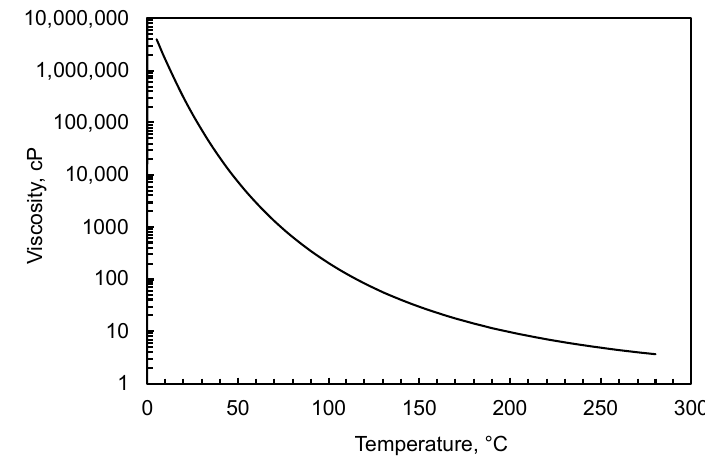
Figure 2. Oil sands viscosity versus temperature profile in Athabasca [11].